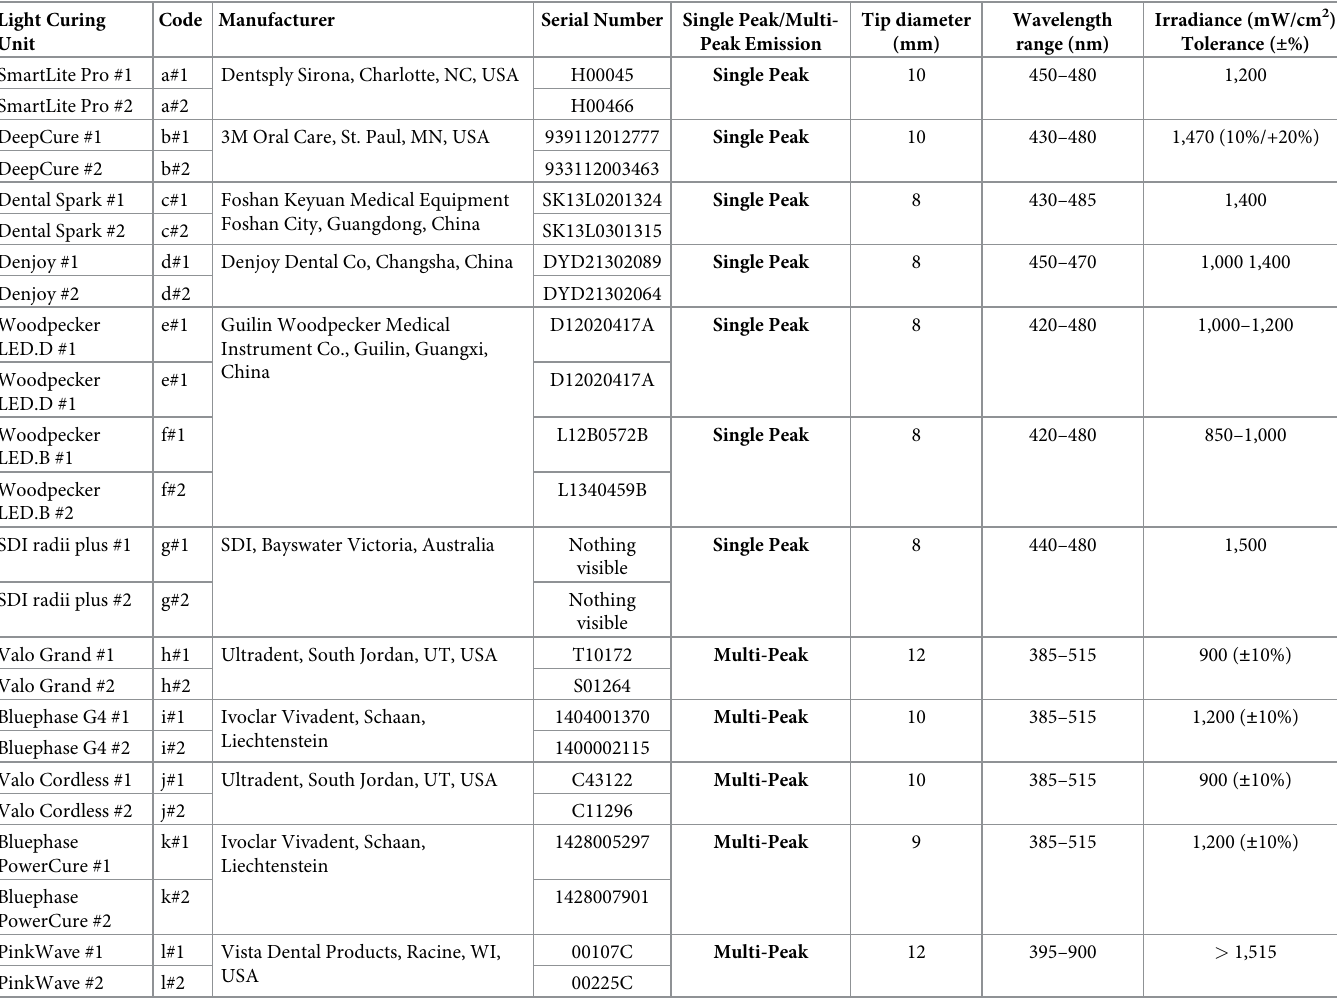
Table 1. Light curing units (LCUs) and information provided by the